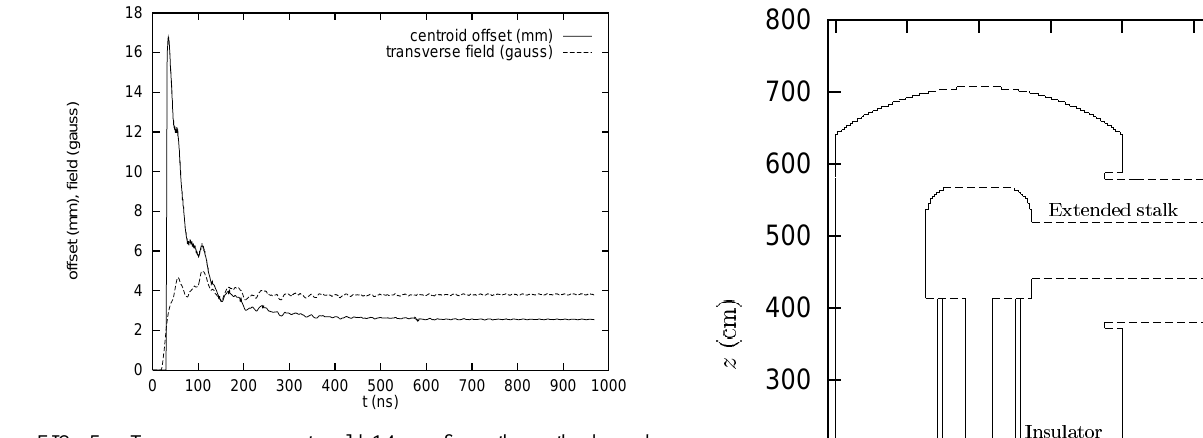
FIG. 5. Transverse magnet field 14 cm from the cathode and beam deflection 30 cm from the cathode. on axis. If the deflecting field were proportional to the